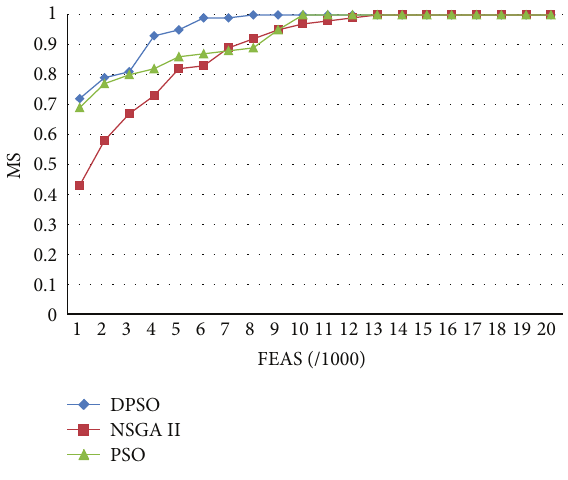
Figure 3: Convergence of 3 algorithms.